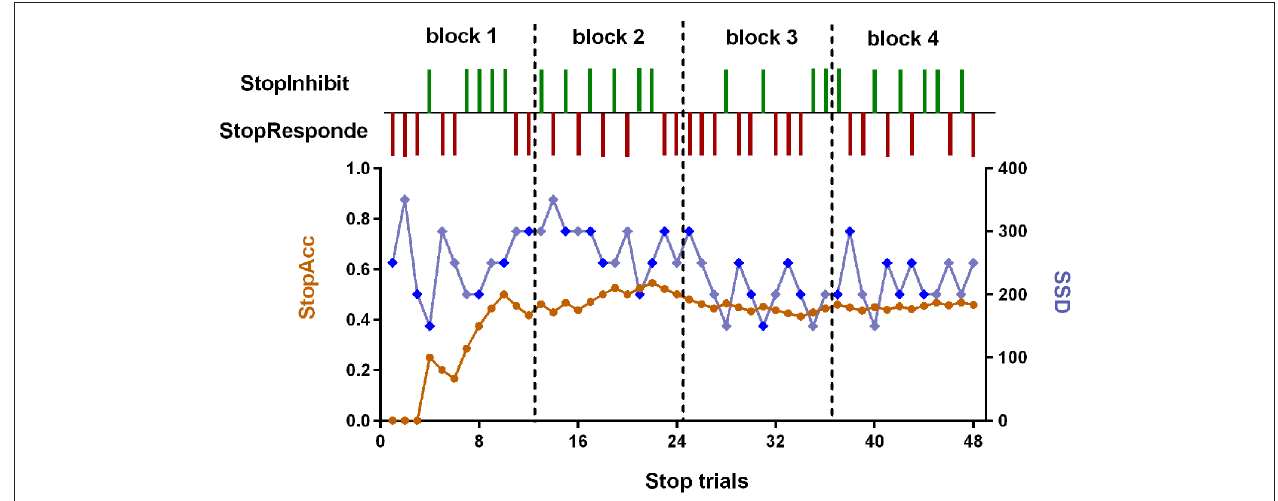
FIGURE 2 | The dynamic changes of SSD and StopAcc across Stop trials of one subject. The green vertical lines represent the successful inhibition (StopInhibit). The purplish red vertical lines represent the failed inhibition (StopResponde). The brown curve (left ordinate) represents the accuracy of Stop trials (StopAcc). The baby blue (right ordinate) curve represents the SSD value. To reduce participants’ anticipation of stimuli, two staircases were used and respectively started with SSD values of 250 and 350 ms (the first two values in the baby blue curve). The dark blue diamond points represent the first staircase with start value of 250 ms. The remaining baby blue diamond points represent the second staircase with start value of 350 ms. If the subject inhibited successfully on a Stop trial, the inhibition was made more difficult on a subsequent Stop trial by increasing the SSD by 50 ms; if the subject did not successfully inhibit, the inhibition was made easier by decreasing the SSD by 50 ms. There were four blocks with 48 Stop trials in total. In each block, six Stop trials corresponded to the first staircase, while the other six Stop trials corresponded to the second staircase. The order of the two staircases was randomized trial-by-trial. For continuity, the start values of the two staircases in block 2 were the last values in block 1, and so on. We can see from this figure that the StopAcc tended to be stable and was about 50% via the dynamical changing the